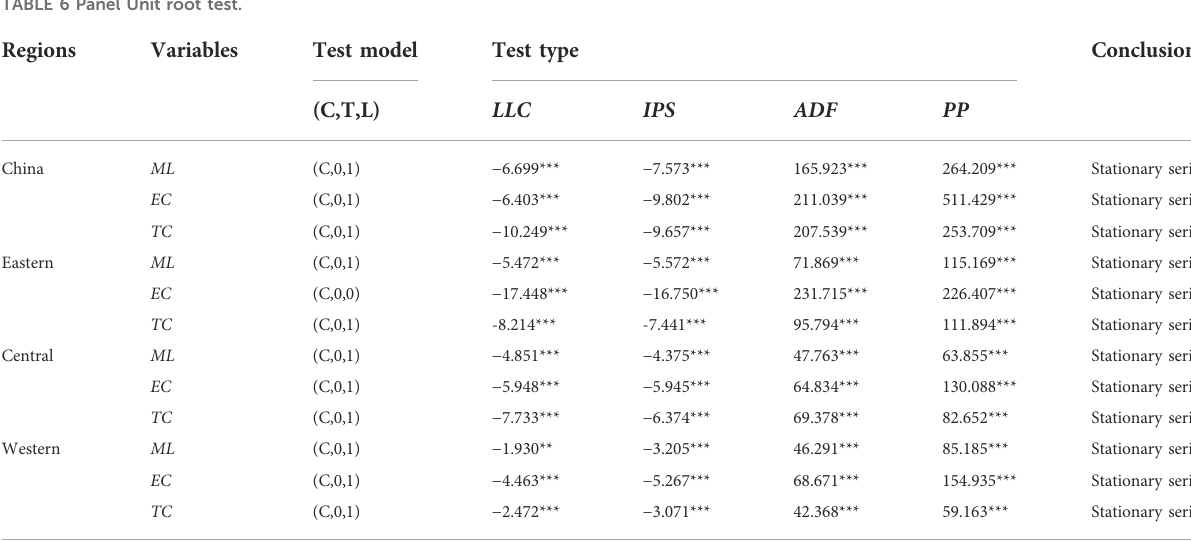
TABLE 6 Panel Unit root